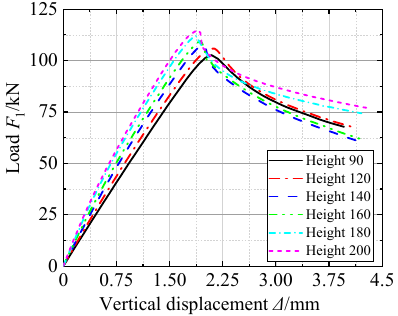
Figure 12. F - Δ relationship curves of C H -40-15-1.5-1500.